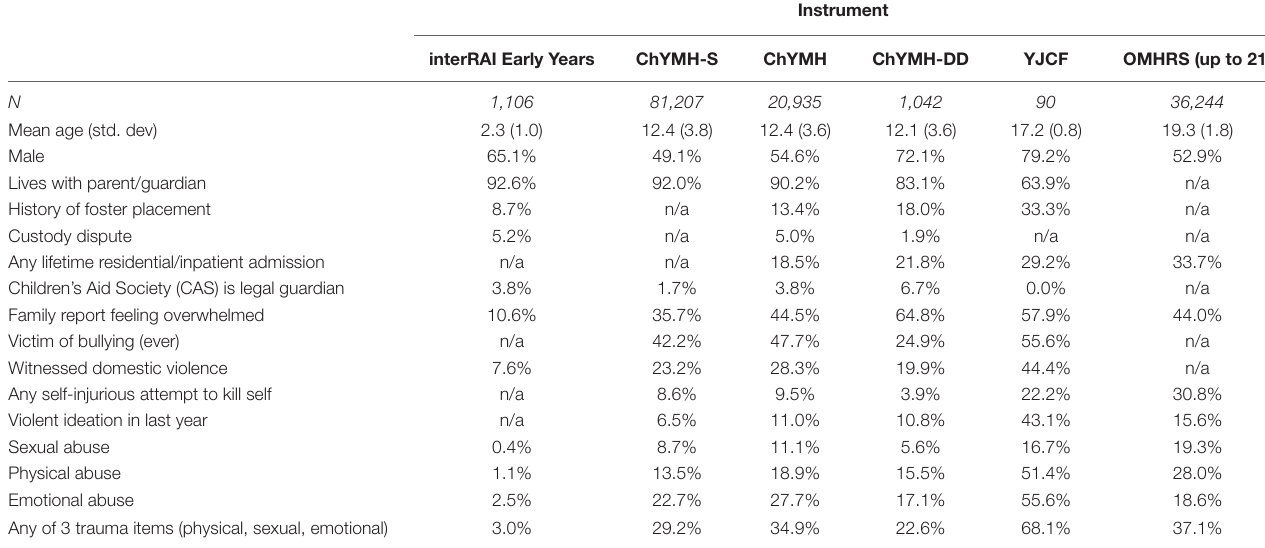
TABLE 5 | Summary of fundamental measures available across child/youth